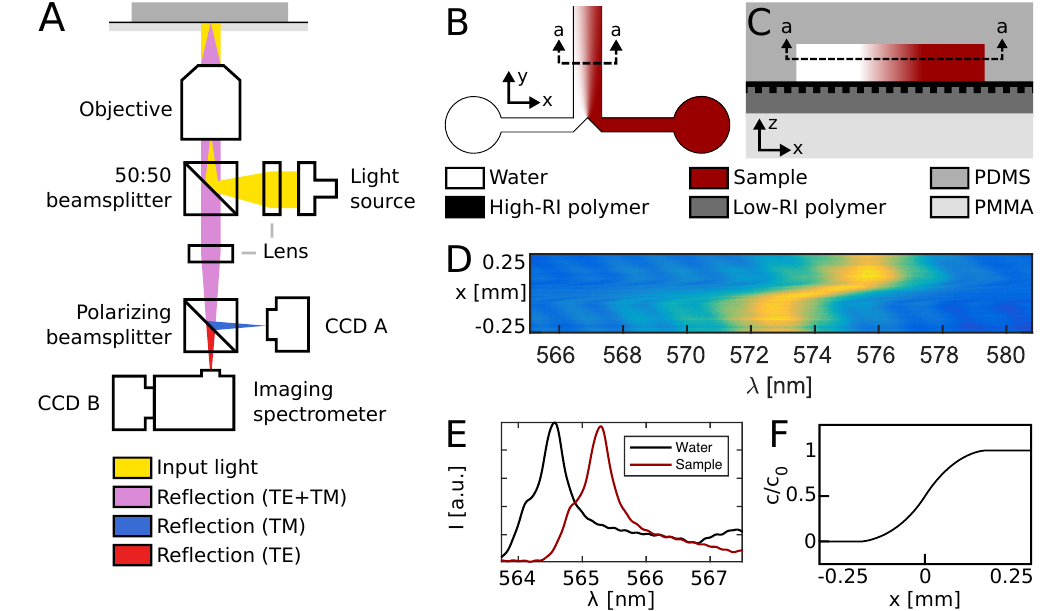
Figure 2. Setup and device operation. ( A ) Schematic overview of optical components. Light reflected by the sensor is received by an imaging spectrometer and used to monitor refractive index changes. ( B ) Top view of the microfluidic system. Two liquid streams co-flow and mix only by diffusion. ( C ) Side view of the sensor-embedded microfluidic H-filter, comprised by four different polymers. ( D ) Sample spectral image showing the concentration gradient. ( E ) Resonance peaks at two positions. The presence of analyte red-shifts the resonance wavelength. ( F ) Diffusion profile as revealed by the embedded